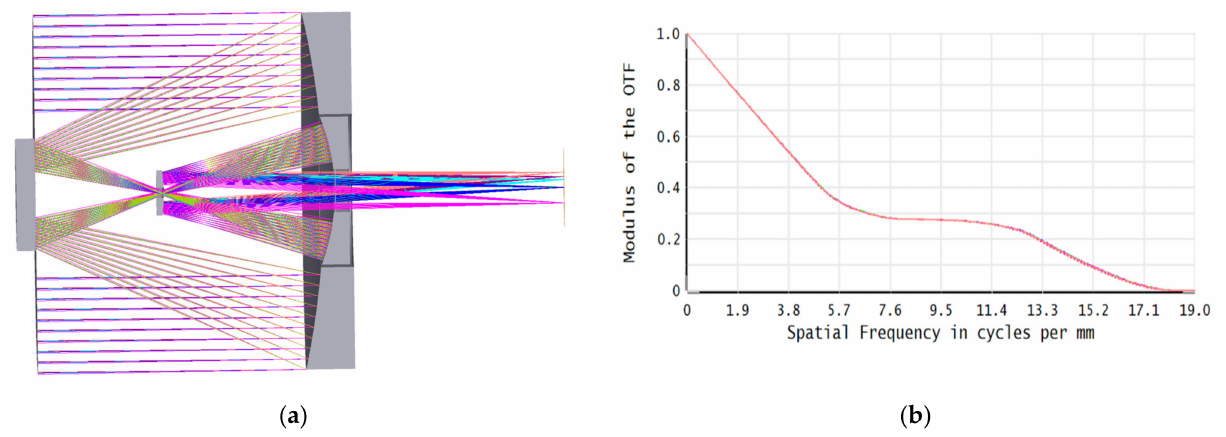
Figure 1. ( a ) Light traces of the optical system; ( b ) MTF